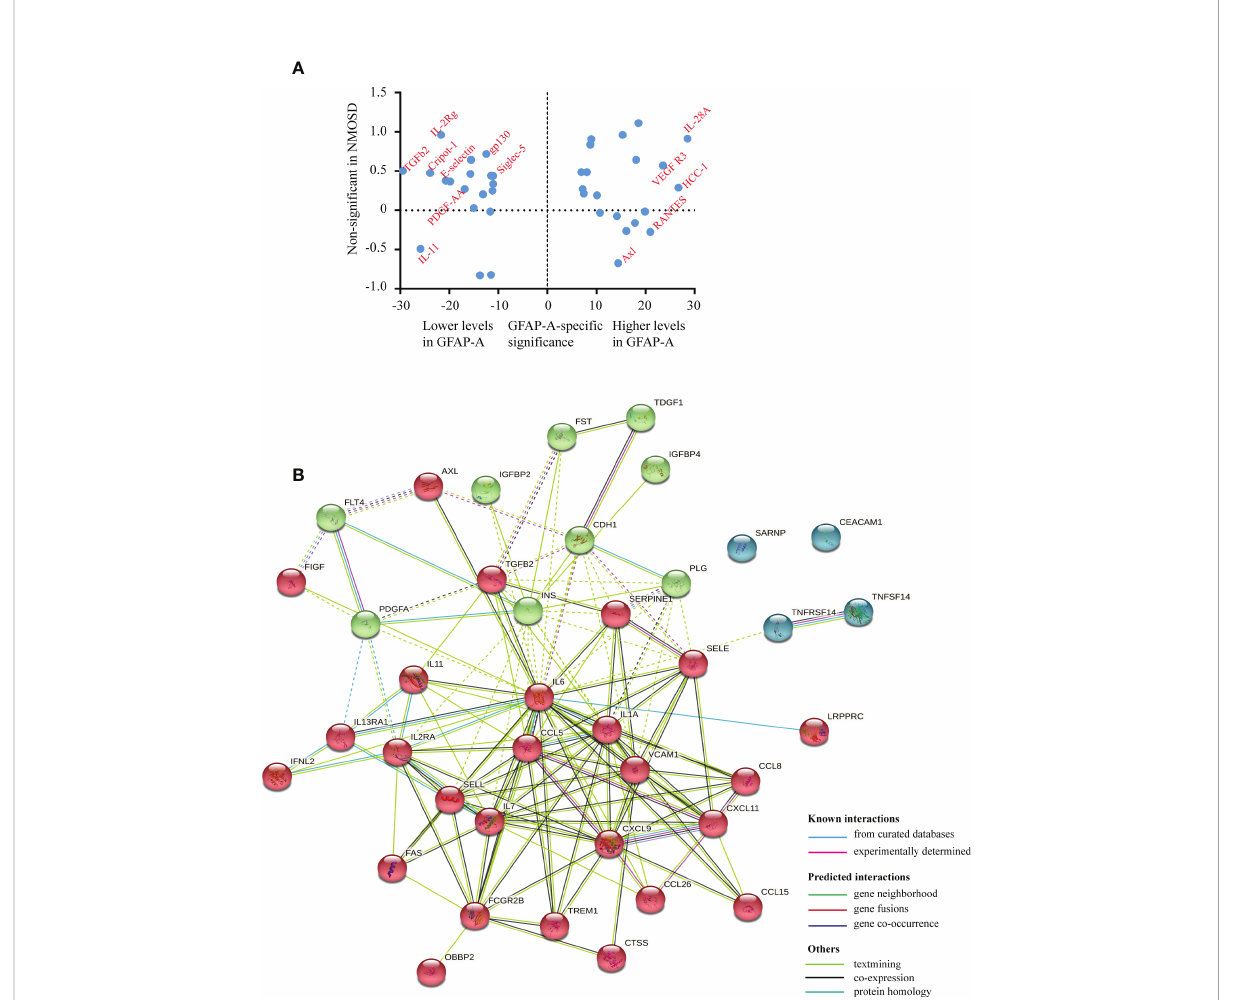
FIGURE 3 Serological protein pro fi les of GFAP-A patient disease-speci fi c information. (A) Plot of the log10-transformed adjusted p value (adj.P.val) of the top 20 upregulated DEPs and top 20 downregulated DEPs unique to GFAP-A patients. The upregulated DEPS, such as VEGF R3, HCC-1, RANTES and Axl, are labeled on the right. The downregulated DEPs, such as E-selectin, gp130, Siglec-5 and PDGF-AA, are labeled on the left. (B) STRING analysis of the 40 DEPs (top 20 upregulated DEPs and top 20 downregulated DEPs). A total of three clusters were identi fi ed with known/ predicted/other interactions. Cluster 1, represented with 26 red balls, and was centered on CXCL9. Cluster 2, represented with 9 green balls, was centered in